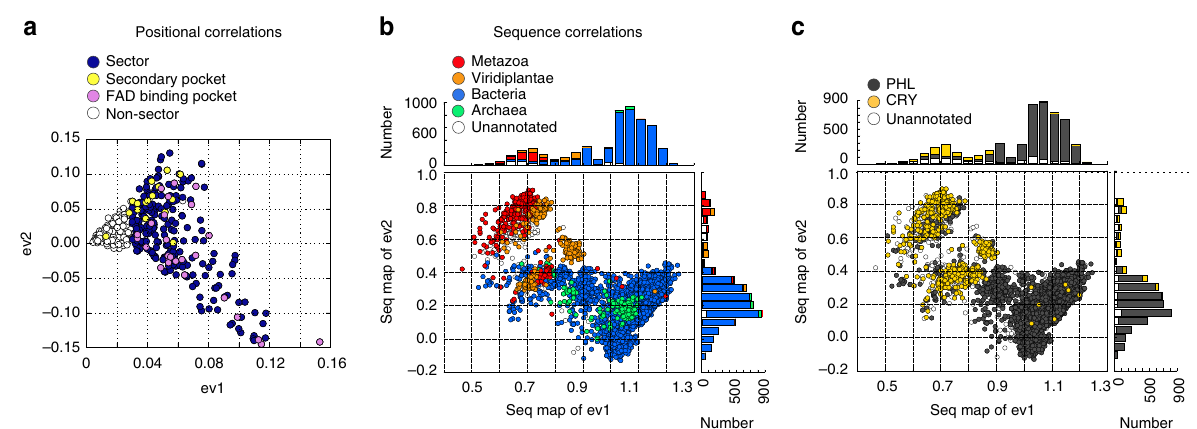
Fig. 2 Statistical coupling analysis indicates that the allosteric secondary pocket is a conserved feature of CPF proteins. a Plot of the top two eigenvectors of the SCA correlation matrix. Each point represents an amino acid position, and amino acid positions that are proximal on this plot show similar patterns of co-evolution. The sector (blue points) is de fi ned along eigenvector 1 (ev1). The secondary pocket positions and FAD-binding pocket positions (as de fi ned in Fig. 1) are shown as yellow and pink dots, respectively. b , c Projection of the positional correlations to sequence divergences. In these plots, each point represents a CPF sequence. The sequences are color-coded either by phylogenetic annotation ( b ) or CRY/PHL annotation ( c ). Sequences which separate into groups along a particular axis diverge in the amino acid positions that separate along the corresponding axis in the sector positions to test the functional role of the secondary pocket in the CRY subfamily.